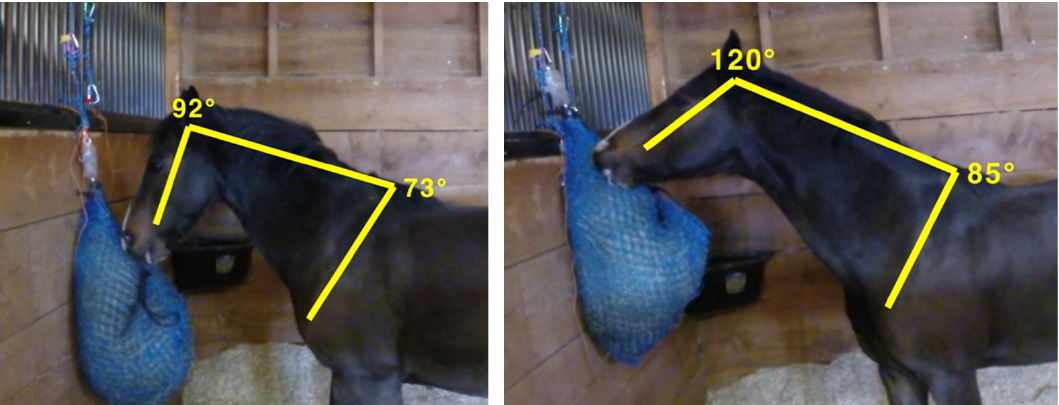
Figure 12. Poll angles recorded when eating from low hung (2.5 cm above withers, left ) and higher hung haynet (30 cm above withers, right ) by the same horse. Images illustrate double netted haynets with same fill size.